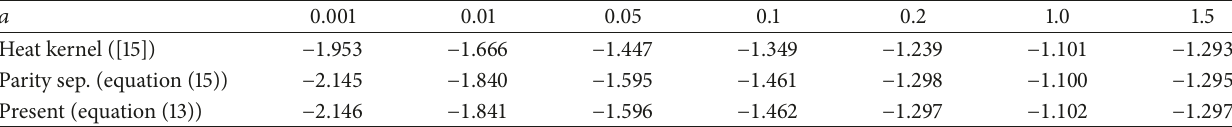
Table 2: Different methods to compute the VPE of the 𝜙 6 soliton for 𝑎 ̸= 0 .